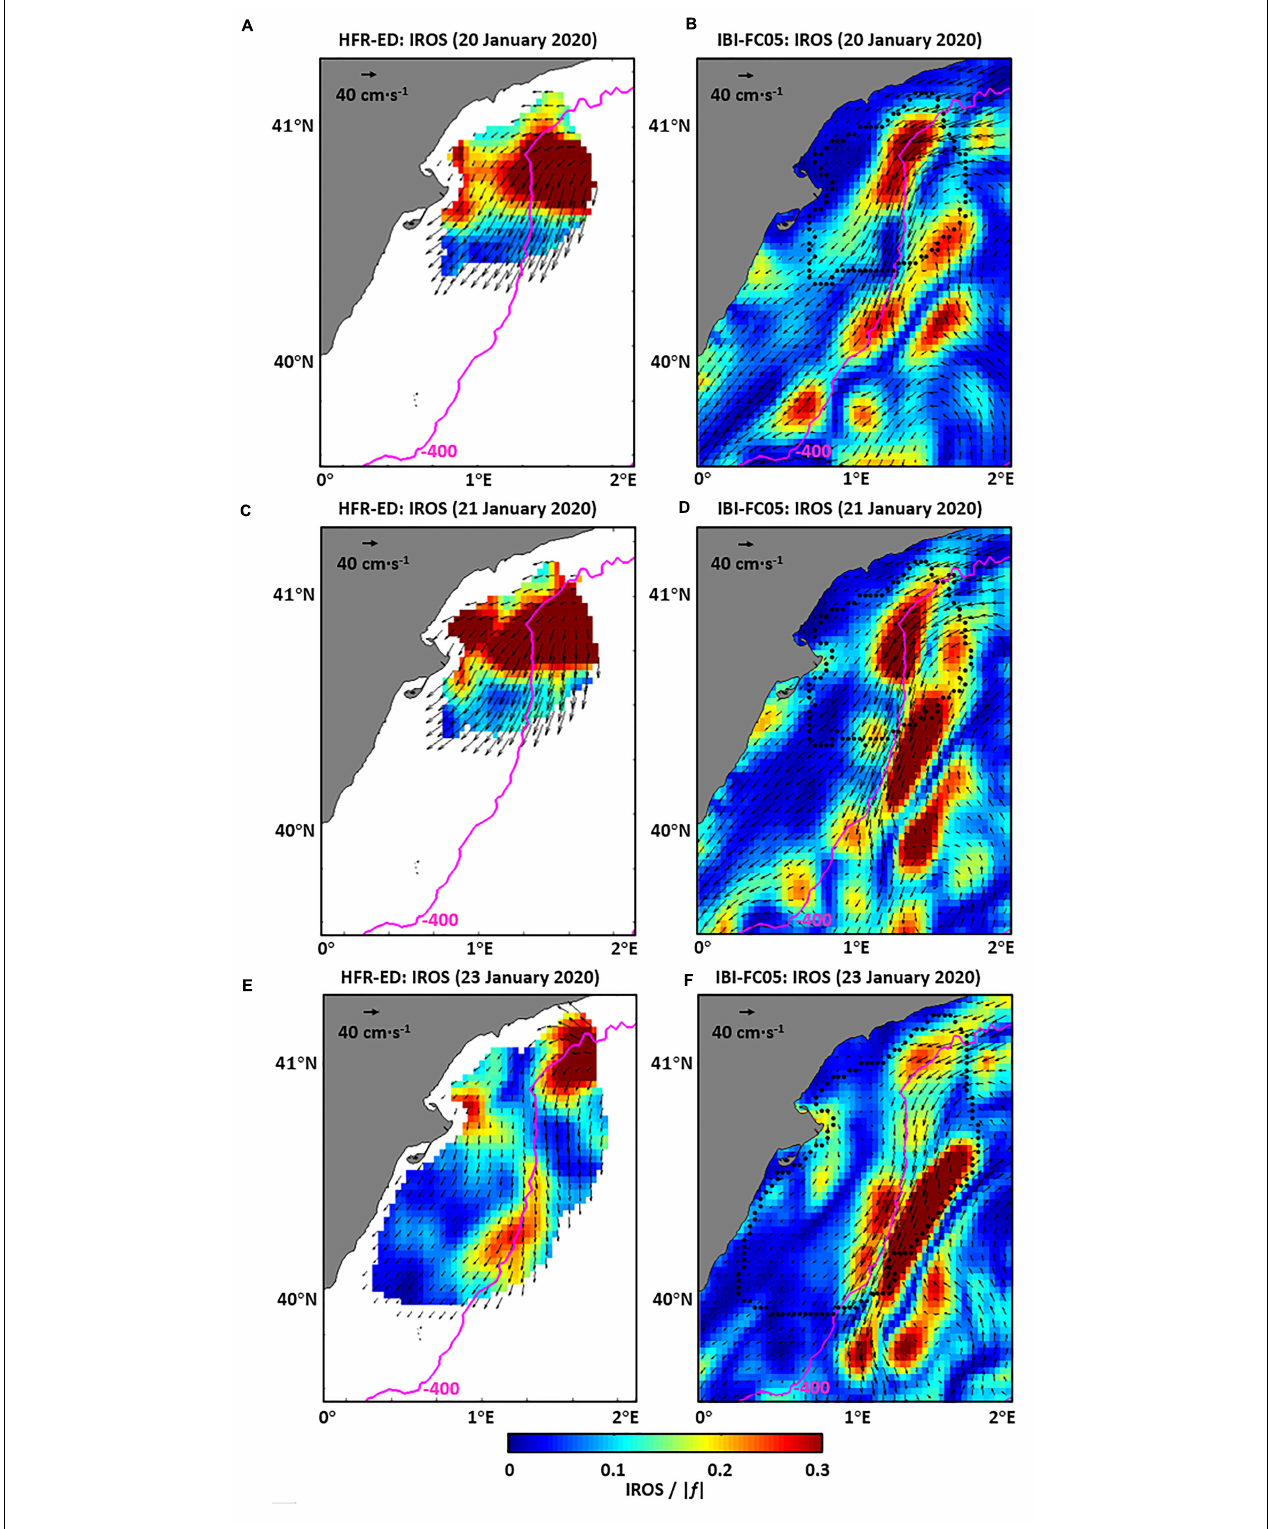
FIGURE 8 | Daily averaged maps of Instantaneous Rate of Separation (IROS) as derived from HFR hourly current estimations (left) and IBI model outcomes five days ahead (right) for the mature stage of storm Gloria (January 20 and 21, 2020) and the dissipating phase (January 23, 2020).